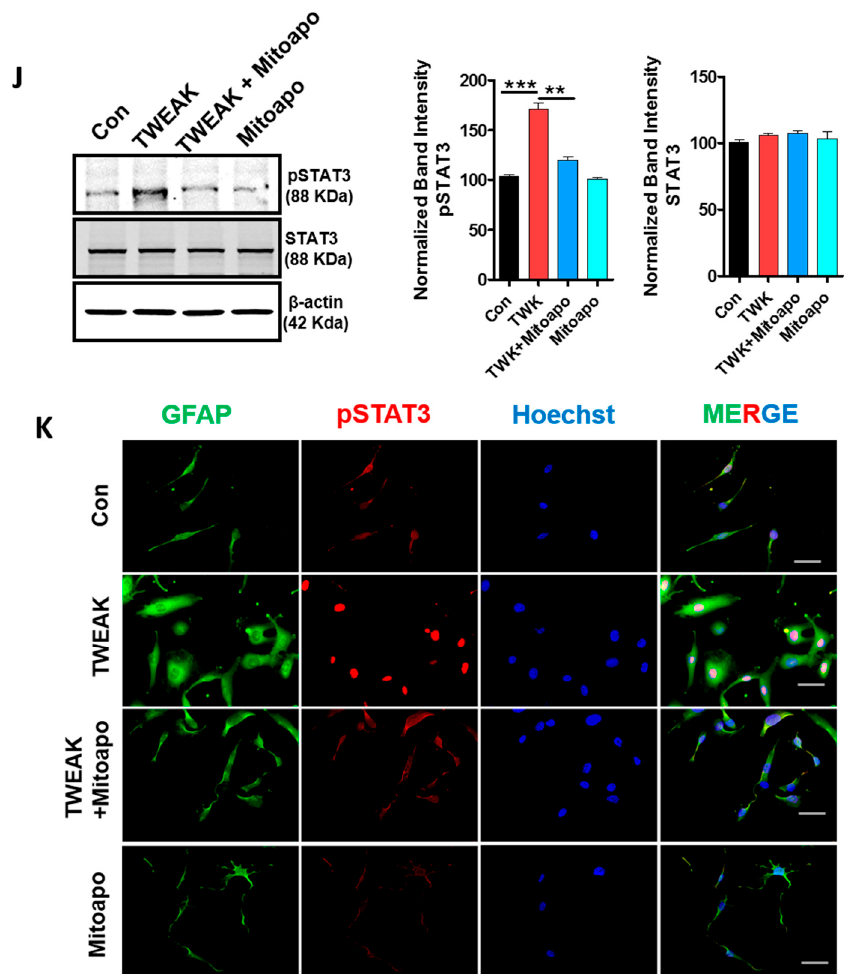
Figure 5. Inhibition of mitochondrial oxidative stress via Mito-apocynin attenuates TWEAK-induced, mitochondria-derived oxidative stress response and nitrosative stress, as well as PKC δ / NLRC4 and STAT3 activation in U373 cells. ( A – E ) Human astrocyte (U373) cells were pretreated with mito-apocynin (10 µ M) for 1 h, and diverse oxidative stress analyses were performed 24 h post-TWEAK treatment. ( A ) MitoSox assay was conducted by incubating the U373 cells with MitoSox dye for 20 min, and the extent of mito ROS was assessed via fluorescence microplate reader. Mito-apocynin significantly reduced TWEAK-induced mitochondrial superoxide levels. Data shown are the mean ± SEM from at least three independent experiments. ( B ) Nitric oxide levels in the supernatant were determined using the Griess assay. Mito-apocynin significantly reduced TWEAK-induced nitrite species generation. Data are expressed as the mean ± SEM from at least three independent experiments. ( C ) ROS generation was measured using the redox-sensitive dye CM-H2DCFDA (1 µ M), and the magnitude of ROS generation was assessed via fluorescence plate reader analysis. Mito-apocynin reduced TWEAK-induced ROS generation. ( D ) MitoTracker assays were implemented to assess changes in mitochondrial morphology in U373 cells. The circularity analysis was indicative of mitochondrial fragmentation, which was significantly elevated in TWEAK-treated cells and ameliorated by mito-apocynin pretreatment. Data are shown as the mean ± SEM from at least three independent experiments. Scale bar = 20 µ m. ( E ) Representative immunofluorescent images show that mito-apocynin pretreatment attenuates TWEAK-induced generation of mitochondrial ROS. Orange / yellow fluorescence, which is indicative of increased generation of mitoROS, was pronounced in TWEAK-stimulated U373 cells. Scale bar = 20 µ m. ( F – I ) Human astrocyte (U373) cells were pretreated with mito-apocynin (10 µ M) for 1 h and analyzed thereafter post-TWEAK treatment for 24 h. ( F , G ) Cell lysates were analyzed for PKC δ , pPKC δ and NLRC4 inflammasome markers, as well as NLRC4, ASC, cleaved-caspase-1 and caspase-1 using Western blot analysis. Representative